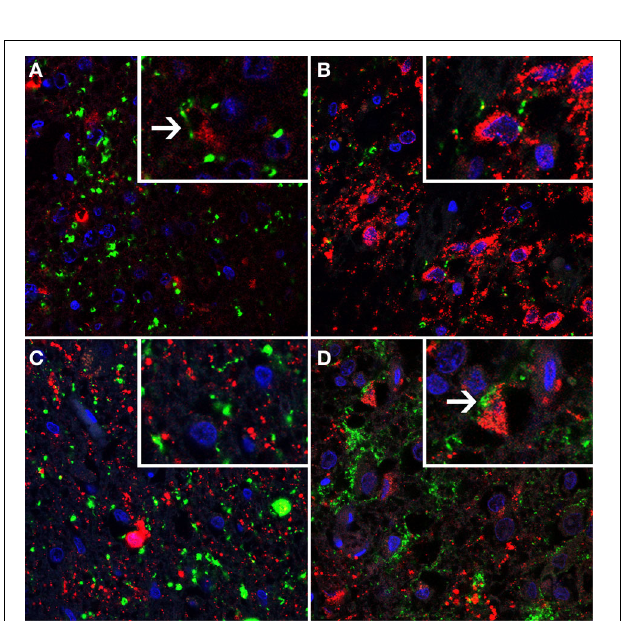
FIGURE 3 | A series of immunofluorescent photomicrographs showing serotonin transporter (SERT)- immunostaining (shown in green) combined with markers for major cell types (shown in red) of suprachiasmatic nucleus (SCN) and infundibular nucleus (IFN). Cell nuclei are shown in blue. SERT immunofluorescent staining (green) combined with (A) arginine vasopressin (AVP, red) in the SCN, high power insert shows SERT staining in close proximity of AVP-positive neurons which was observed in a very small minority of cells; (B) Vasointestinal peptide (VIP, red), high power insert illustrates the absence of SERT immunoreactivity surrounding VIP-positive neurons; (C) Neuropeptide Y (NPY, red), and (D) α Melanocyte stimulating hormone ( α MSH, red), note the SERT staining surrounding the α MSH positive neurons.